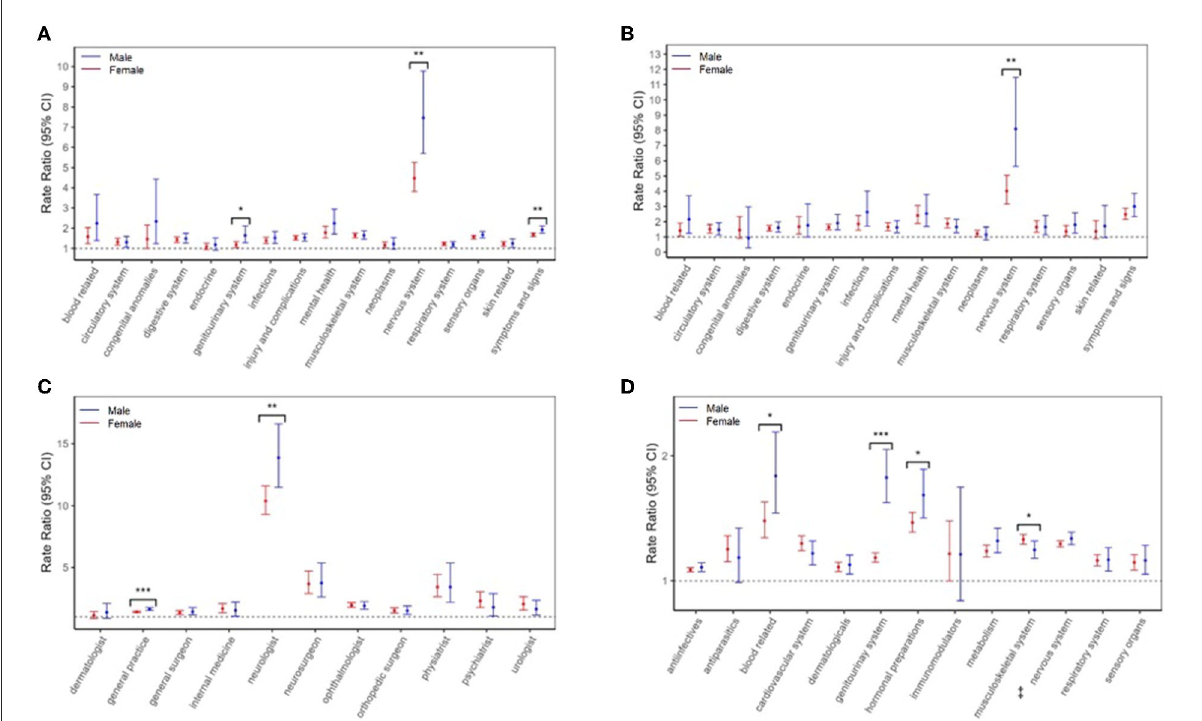
FIGURE1 Multiple sclerosis (MS) cases vs. controls in the 5 years before the first demyelinating diagnostic code: sex-specific rate ratios for (A) physician visits and (B) hospitalizations per International Classification of Diseases-9/10 chapter, (C) physician visits per specialty, and (D) prescriptions-filled per Anatomical Therapeutic Chemical (ATC) level 1 classification. Results were not reported if a model failed to converge due to low counts or the 95% CIs were wide (exceeded 100). * P < 0.05, ** P < 0.01, *** P < 0.001 indicates that the rate ratios were statistically different between men and women, based likelihood ratio tests. ‡ Amantadine was categorized as a nervous system drug, based on the Anatomical Therapeutic Chemical (ATC) level I classification system.